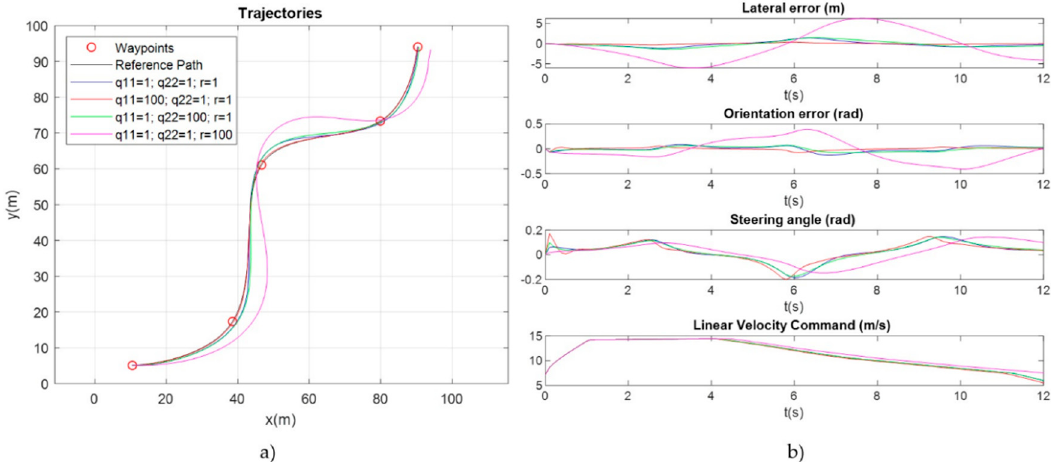
Figure 6. Influence of LQR controller parameters in the trajectory, the tracking errors and the control signal: ( a ) Resulting trajectories using (1) the same value for all the parameters (blue line), (2) a higher value for q 11 (red line), (3) a higher value for q 22 (green line) and (4) a higher value for r (magenta line); ( b ) tracking errors, control signal (steering angle) and linear velocity command provided by the linear velocity profiler.